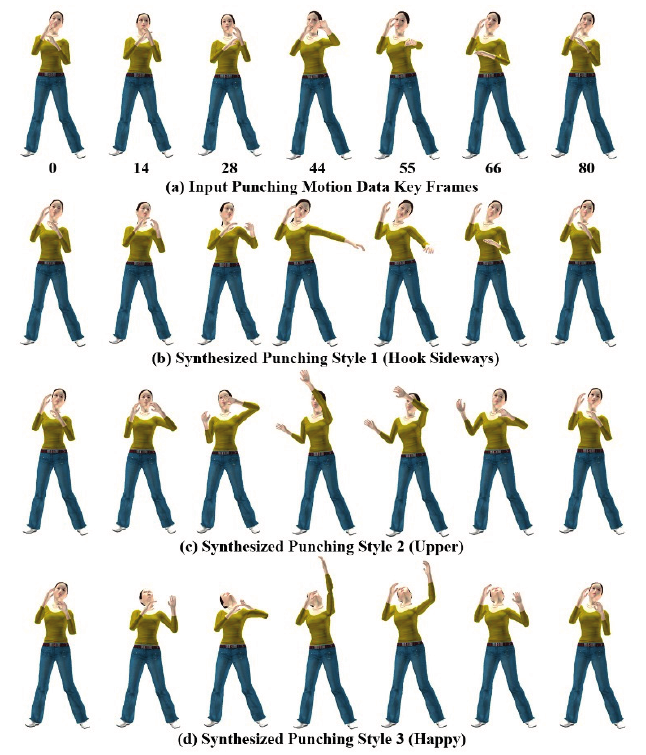
Figure 10. Punching motions of